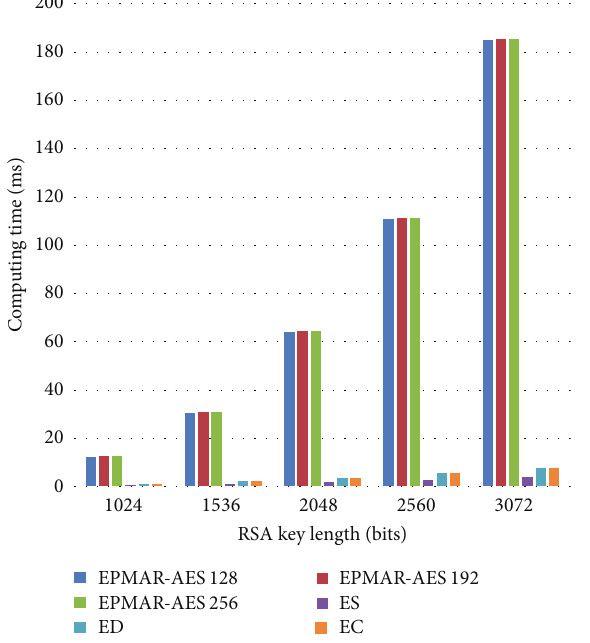
Figure 14: Reader’s computational time—offline transaction.